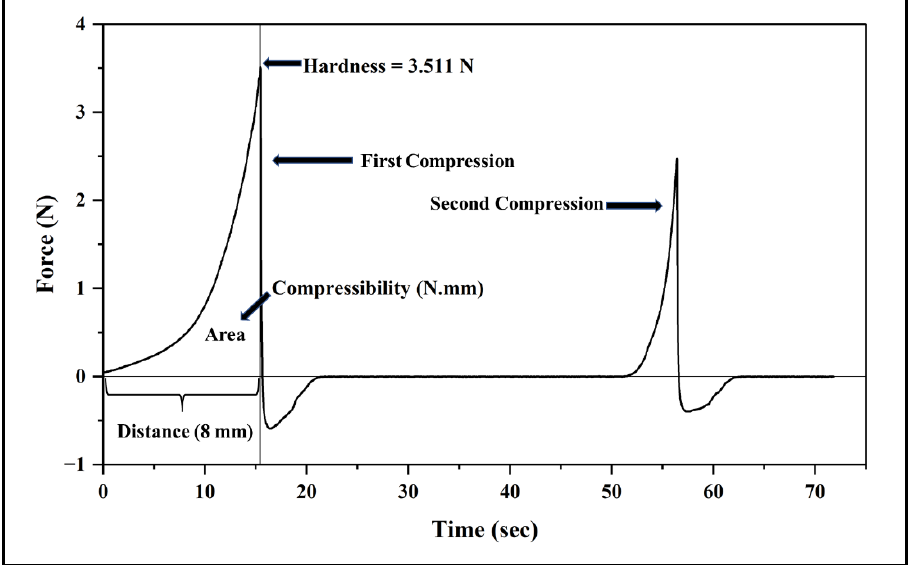
Figure 4. Force-time curve obtained from the texture analyzer for a waiting time of 1 min.